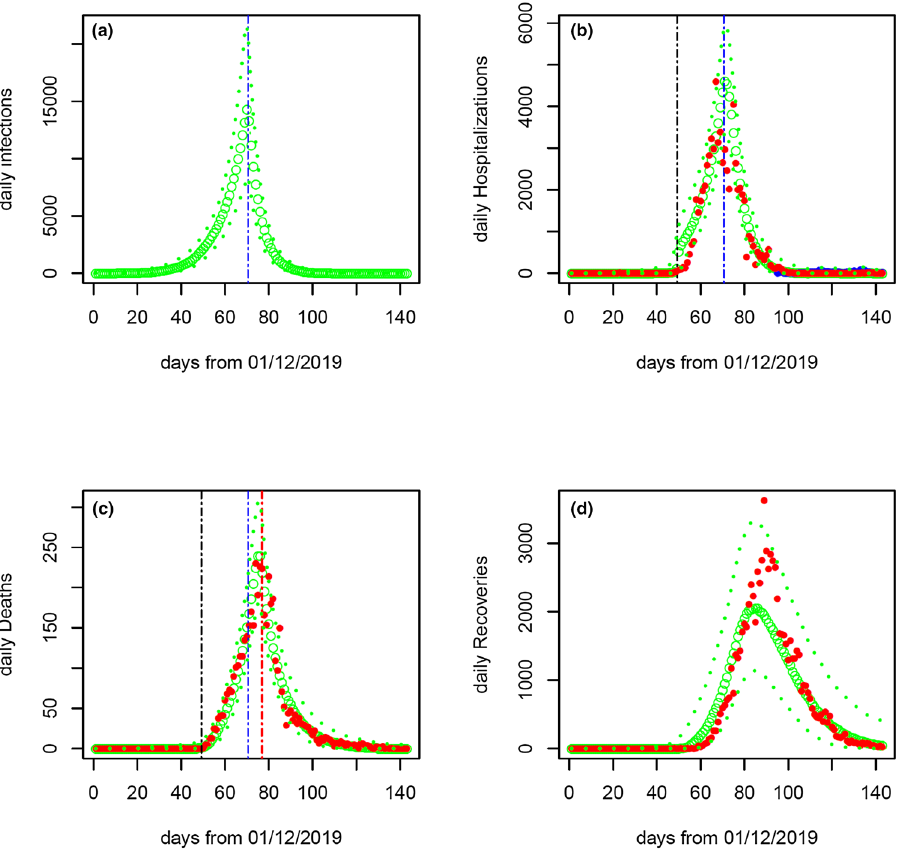
Figure 2. Epidemic curves from 1st December 2019 to 21st April 2020. Model predictions of infections (panel a ) and model fitting to the daily numbers of confirmed cases (panel b ), deaths (panel c ) and recovered cases (panel d ) are shown. The model predictions are obtained after redistributing the 1290 deaths added to the official data on 17th April 2020 to the period before 20th February 2020 in accordance with the daily number of deaths reported before 17th April 2020. The green dotted lines represent the model predictions (large green circles for median and thin green dotted lines for lower and upper levels of 95% confidence interval). The red points are the observed data. The black, blue and red vertical lines denote the estimates of times when the case ascertainment rate, transmission rate and confirmed case fatality rate respectively are estimated to have changed. In panel ( b ), the blue points represent daily number of imported cases which are nearly invisible. Note that the daily number of confirmed cases (15,152) on 12th February 2020 (day 74) is beyond the range shown in panel ( b